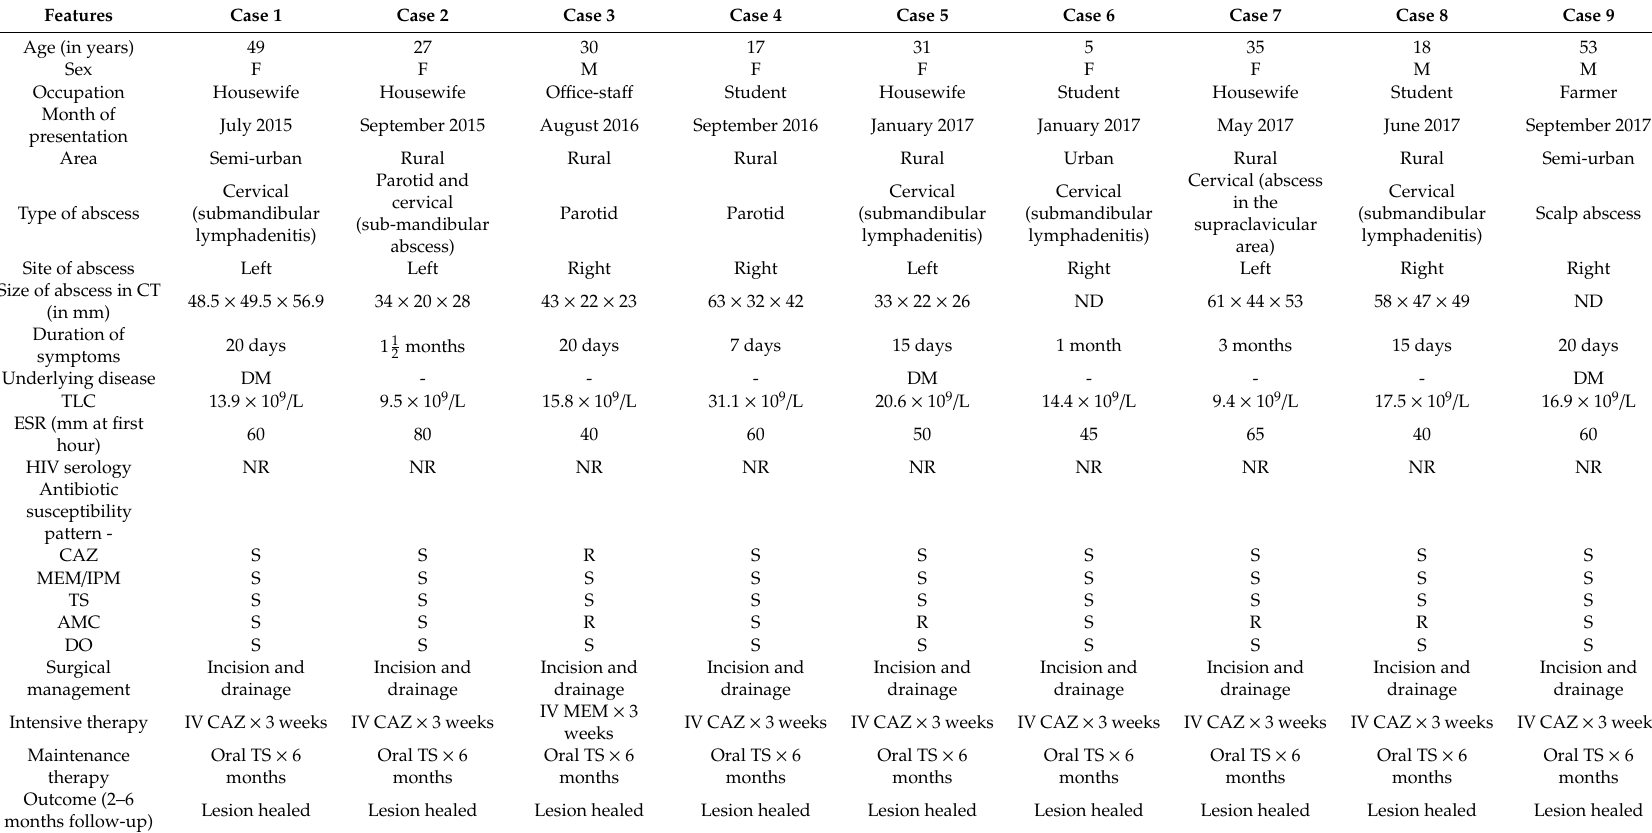
Table 1. Clinical and bacteriological summaries of nine patients with melioidosis of head and